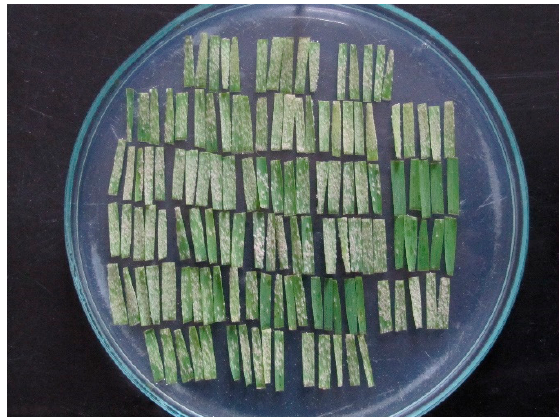
Figure 1. Twenty-six wheat cultivars each represented with a pentad of leaf segments seven days after inoculation with a Blumeria graminis f. sp. tritici isolate.